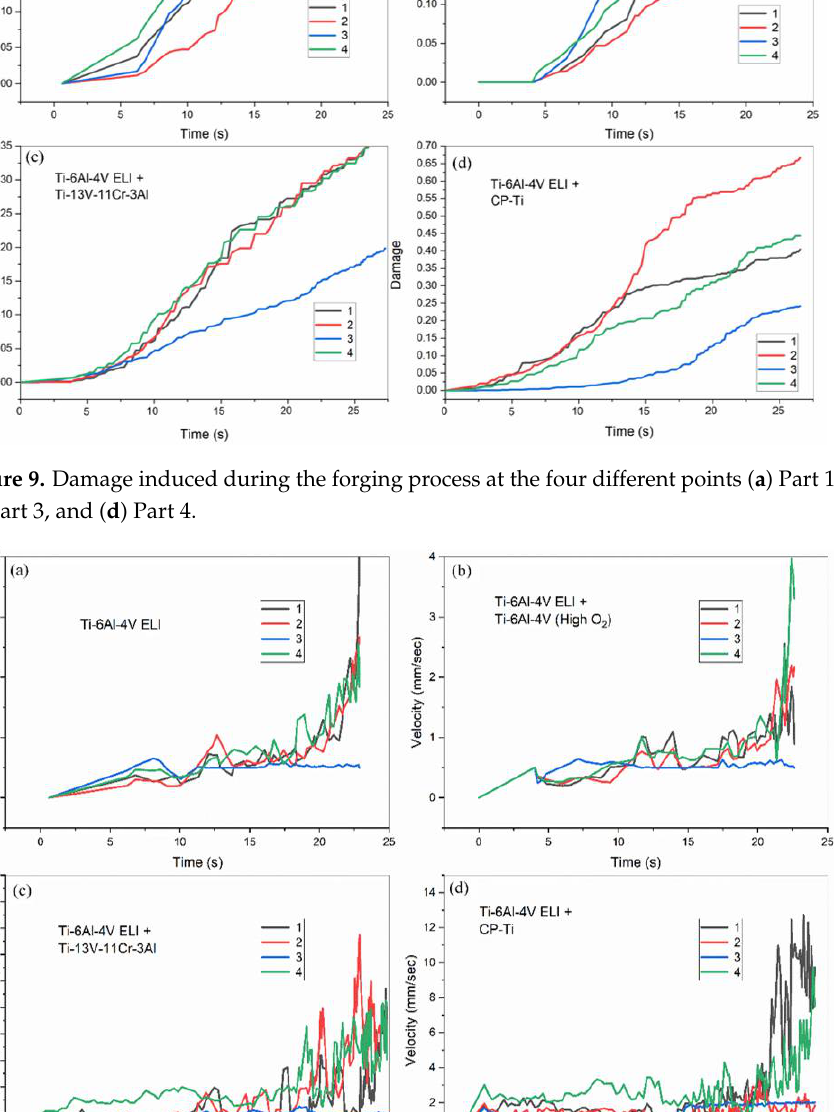
Figure 10. Velocity (rate of change of position of four points) at the four different points ( a ) Part 1, ( b ) Part 2, ( c ) Part 3, and ( d ) Part 4.